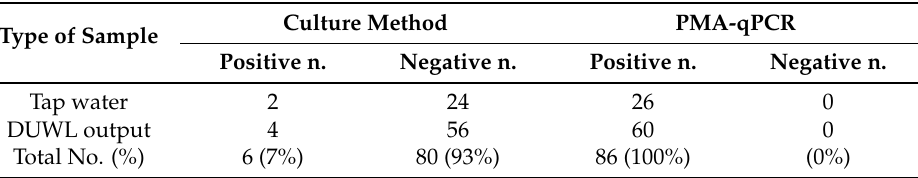
Table 1. Prevalence of Legionella spp. in water samples, as determined using PMA-qPCR and culture